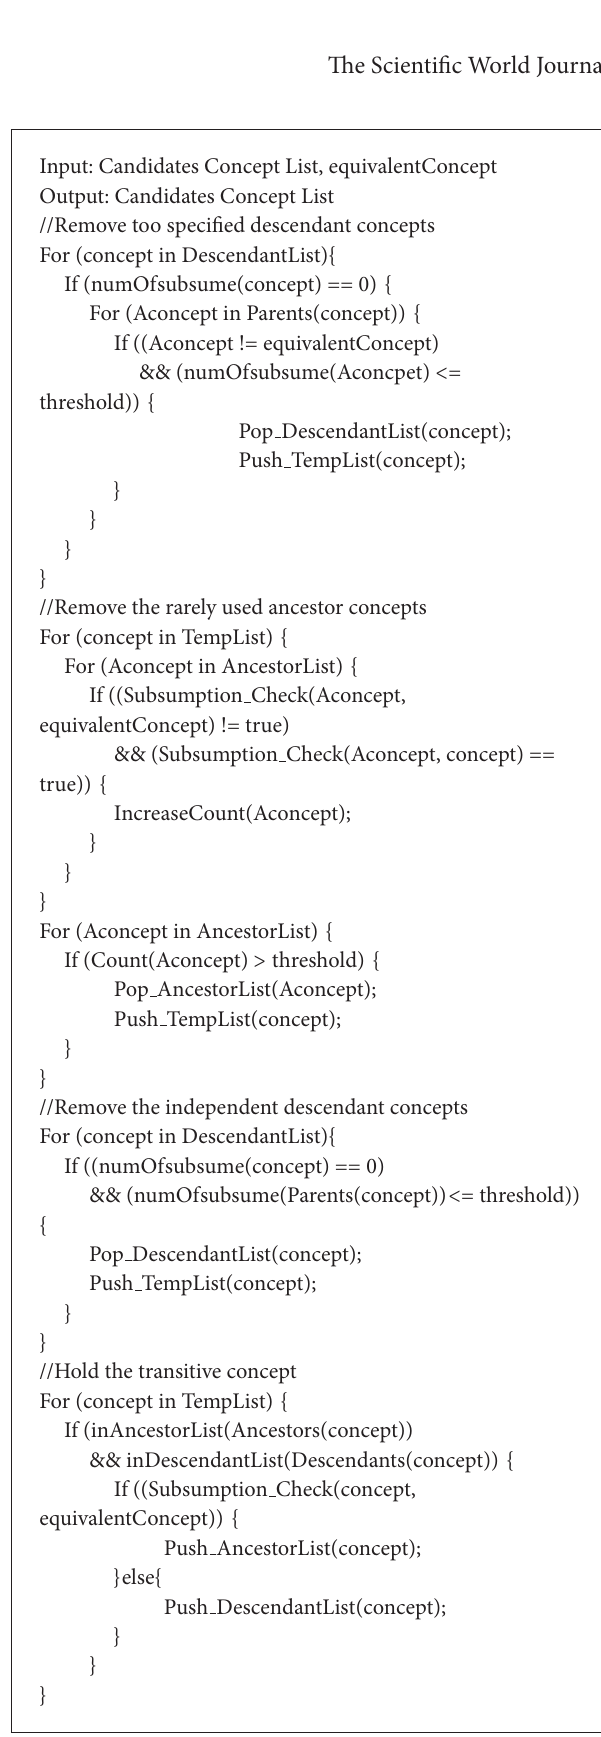
Algorithm 3: Algorithm of module extraction (concept